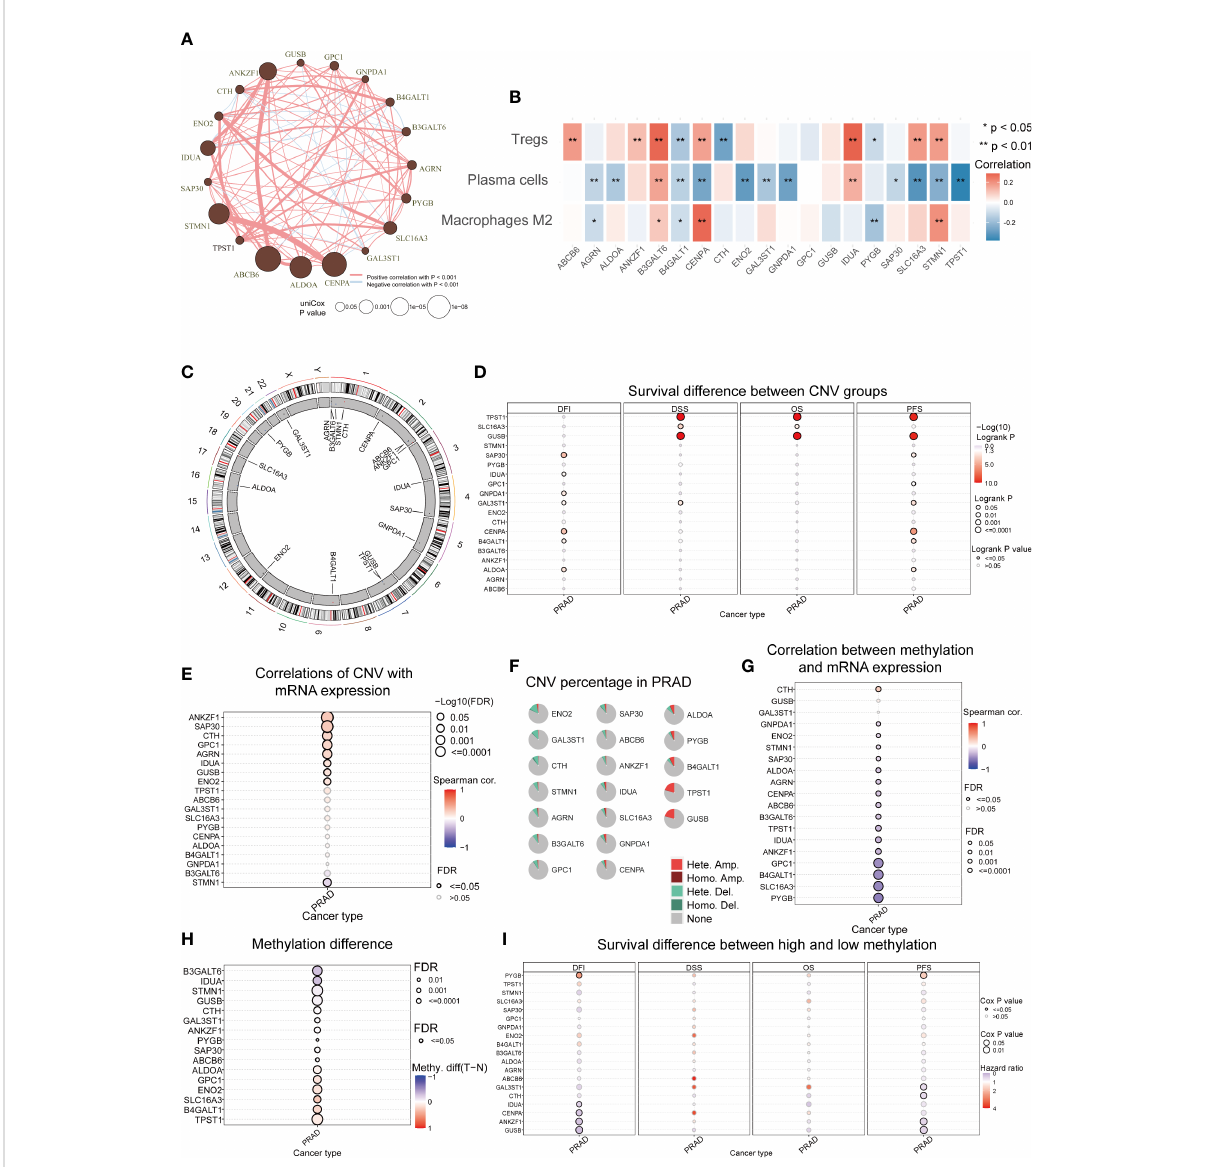
FIGURE 5 Aberrant GRGs in multi-omics analysis. (A) Interactions among 19 GRGs in PRAD. The circle sizes represent the P values obtained by univariate Cox regression analysis. Positive associations are marked in red, whereas negative associations are depicted in blue. (B) The correlation of 19 GRGs in the Glycolysis Score with the abundance of 3 TME cells in the TME Score. (C) The location of CNV alterations of GRGs on chromosomes. The red dots represent CNV gain while blue dots represent CNV loss. (D) The correlation between CNVs of GRGs and prognosis including disease-free interval (DFI), disease-speci fi c survival (DSS), overall survival (OS) and progression-free survival (PFS). (E) Relationships between CNVs and mRNA expression. (F) Summary of CNV in GRGs. (G) Relationships between DNA methylation and mRNA expression. (H) Methylation difference between tumor and normal. (I) The association between methylation of GRGs and DFI, DSS, OS,